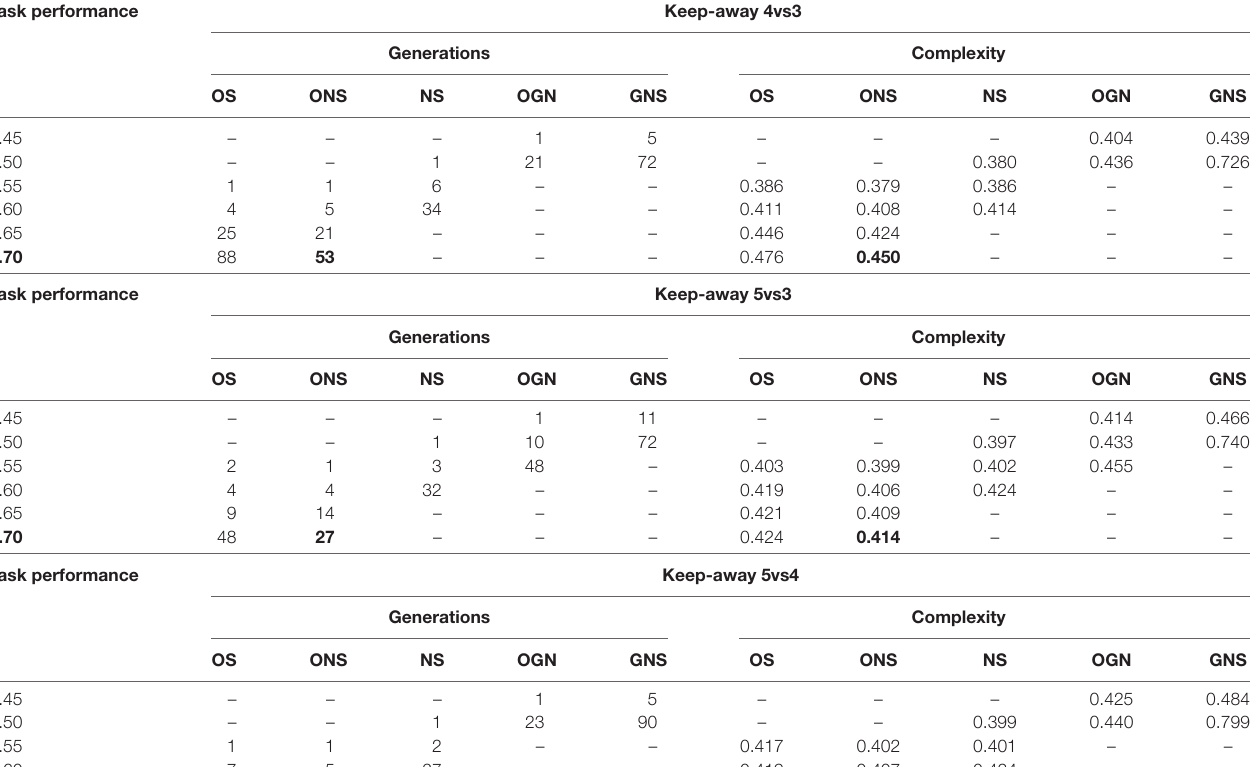
TaBle 7 | Average normalized CPPN complexity (neurons and connections, over 20 runs) for the fittest behaviors evolved by each HyperNEAT variant for each keep- away